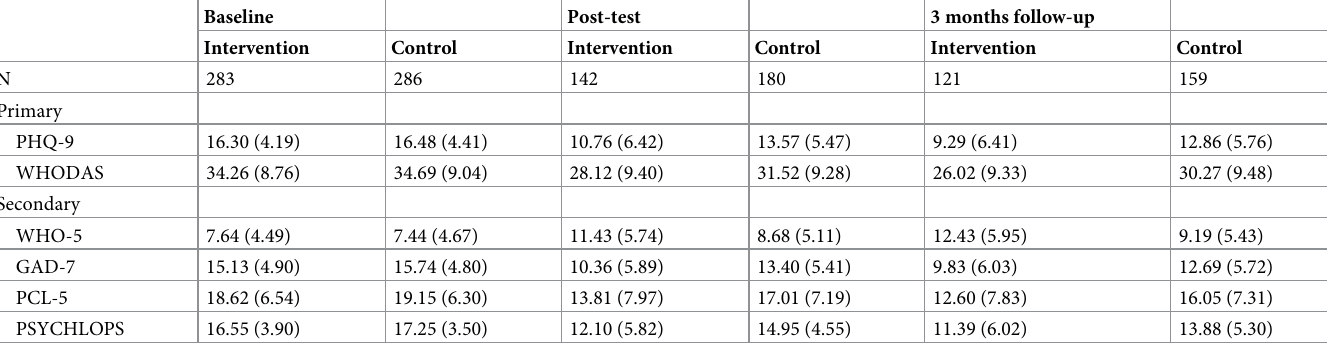
Table 2. Inferential statistics of treatment outcome measures for complete cases: Means, standard deviation and